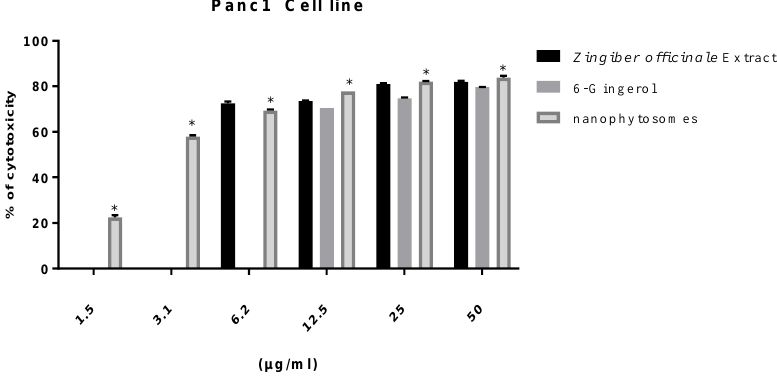
Figure 3. Effect of Zingiber officinale extract, 6-gingerol, and 6-gingerol-loaded PEGylated nanophytosomes on cytotoxicity of Panc1 cells compared with control (6-gingerol). * Statistically different at significance level p < 0.05.